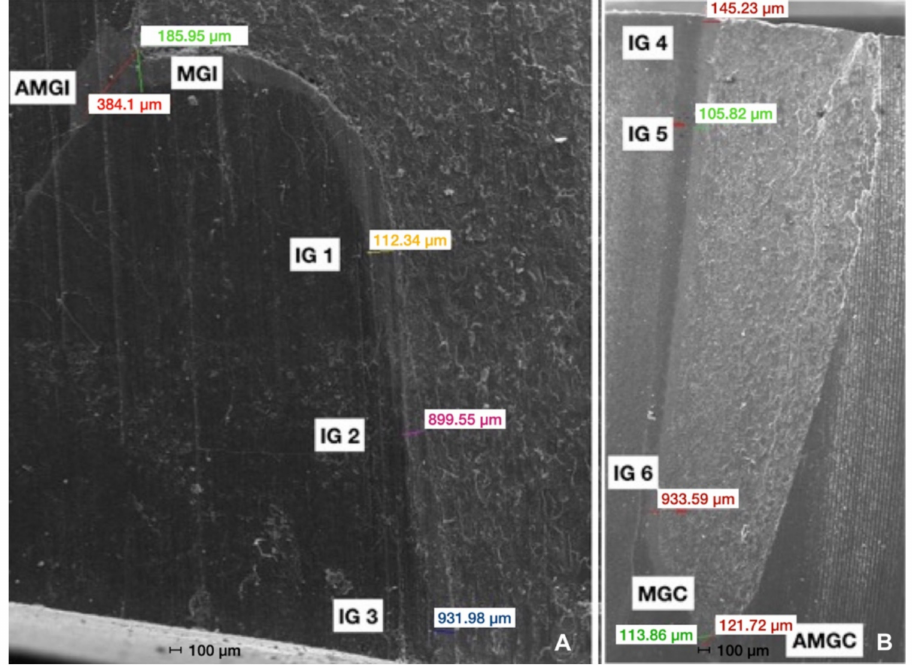
Figure 4. ( A ) Digital image of the incisal section. AMGI: Absolute Marginal Discrepancy at the Incisal edge. MGI: Marginal Gap at the Incisal edge. IG: Internal Gap; IG1 was measured at 1 mm distance from the incisal edge, IG2 was measured at 1 mm distance from the midline section toward the incisal, and IG3 was measured at the midline section. ( B ) Digital image of the cervical section. AMGC: Absolute Marginal Discrepancy at the Cervical edge. MGC: Marginal Gap at the Cervical margin. IG: Internal Gap; IG4 was measured at the cervical midline section, IG5 was measured at 1 mm distance from the midline section toward the cervical, and IG6 was measured at 1 mm distance from the cervical